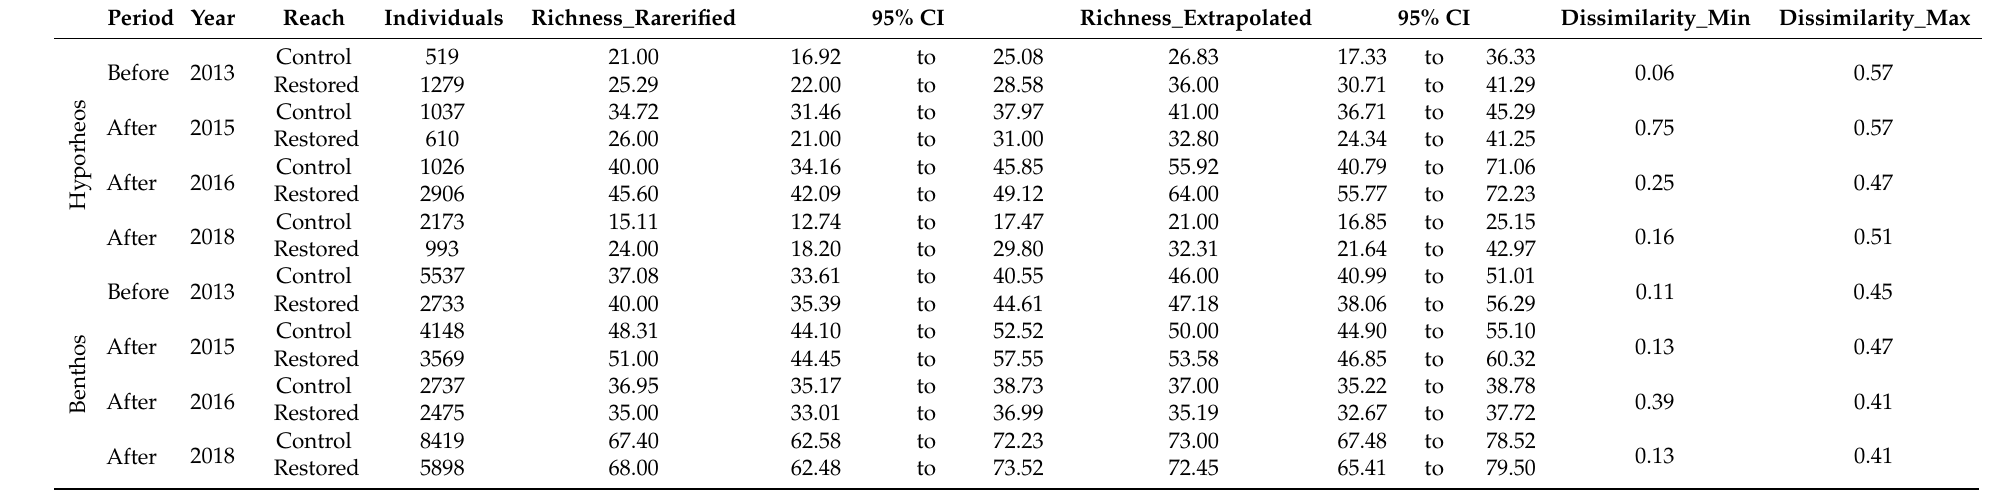
Table 1. Summary statistics for sample-size based rarefaction and extrapolation diversity curves and beta-diversity dissimilarity (CNESSa)